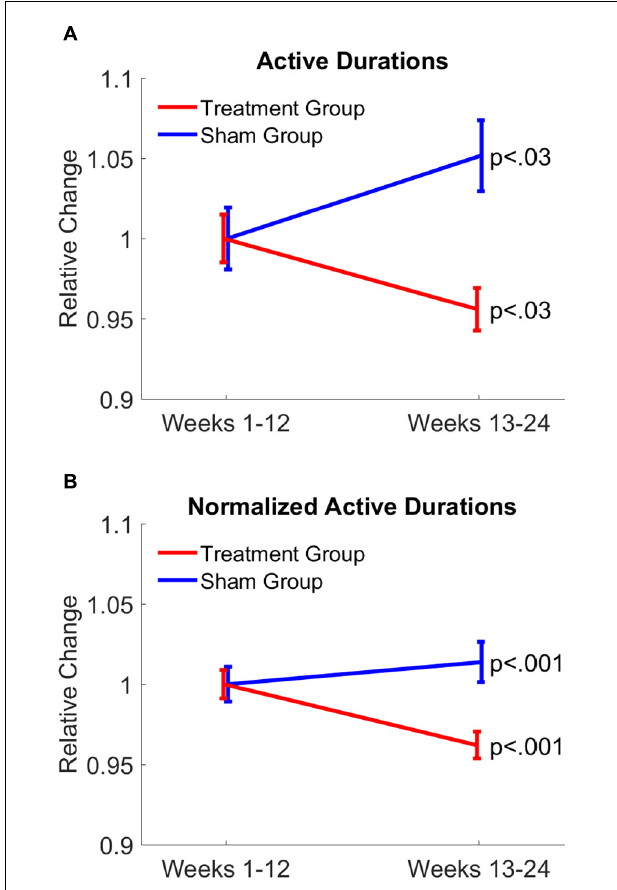
FIGURE 4 | Gamma sensory stimulation therapy reduced duration of active periods during nighttime. Changes in durations of active periods in treatment group is shown in red and sham group is shown in blue from the first 12 weeks to the last 12 weeks of the therapy (A) . Active durations were normalized by dividing duration of each active period by the duration of the corresponding nighttime period (B) . Changes observed in the treatment group (red) indicate a significant reduction in duration of active periods, indicating an improvement in sleep quality, while the opposite can be assessed in the sham group